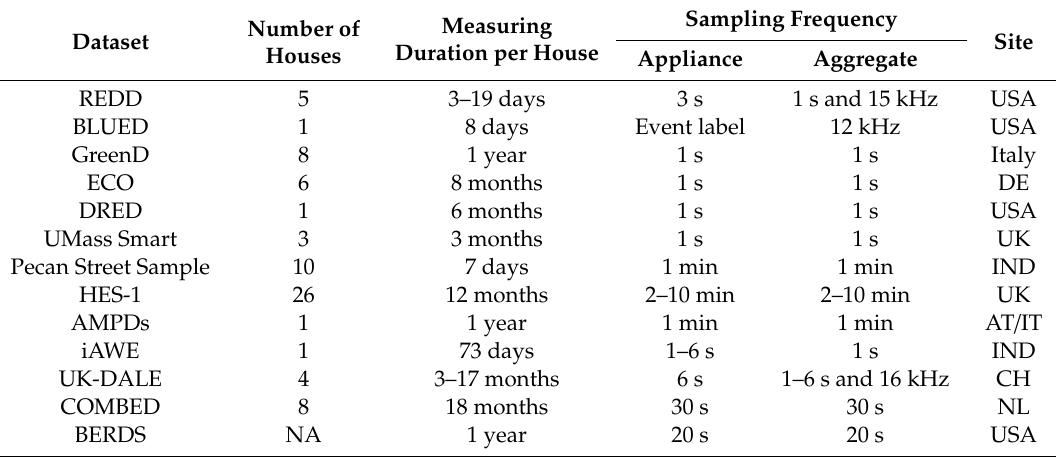
Table 1. Publicly available datasets of household energy consumption